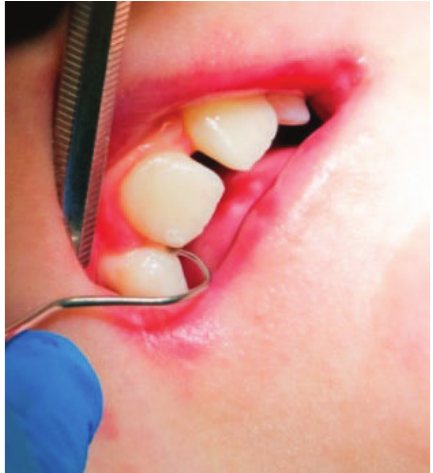
Figure 3: Final result of conservative